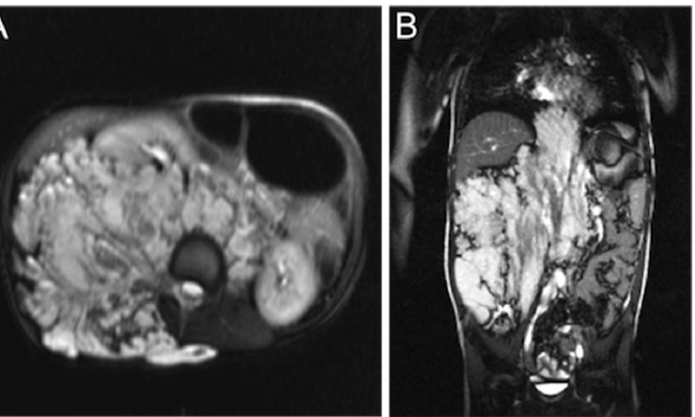
Figure 2. Axial ( A ) and coronal ( B ) T2-weighted MR images of an extensive VM affecting the retroperitoneum and spinal muscles and dislocating the bowel and the right kidney to the left. Table 2. Abnormalities in blood cell count, coagulation factors, and natural anticoagulants.